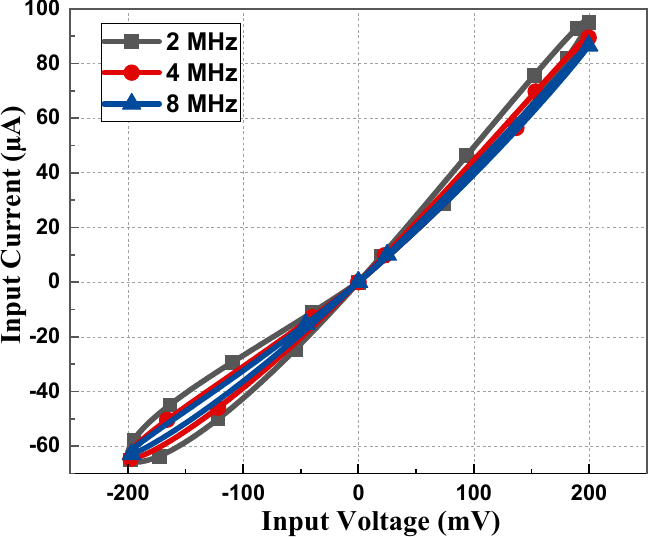
Figure 5. PHL at 1, 2, and 5 MHz with 50 pF capacitor value for incremental configuration.